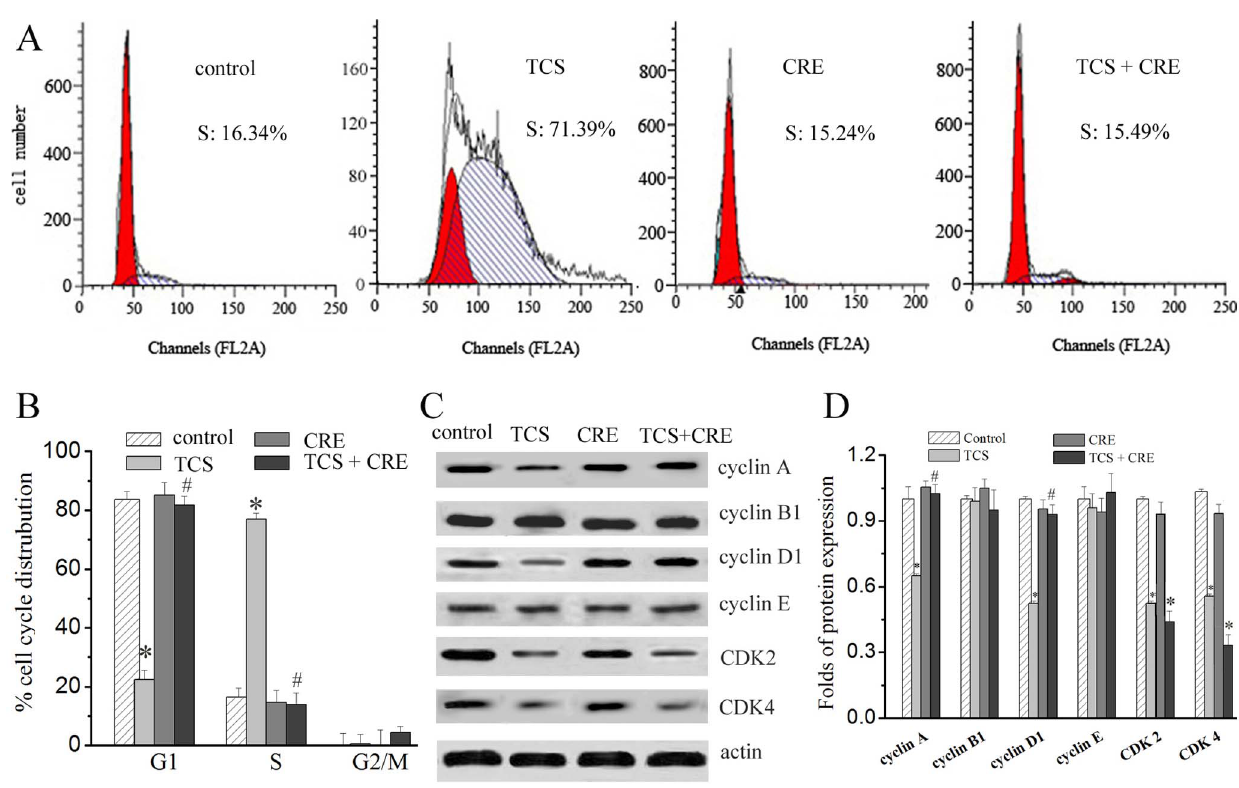
Figure 5. Effects of CRE-decoy on HeLa cell cycle progress and regulatory proteins. TCS-induced increase of cell numbers in S phase was significantly attenuated by the combined treatment of TCS + CRE (A, B). The down-regulated expression of cyclin A and D1 was reversed by TCS + CRE. No effect was observed on other proteins (C, D). Data represent means 6 SD of three independent experiments (* p , 0.05 compared with control, # p , 0.05 compared with